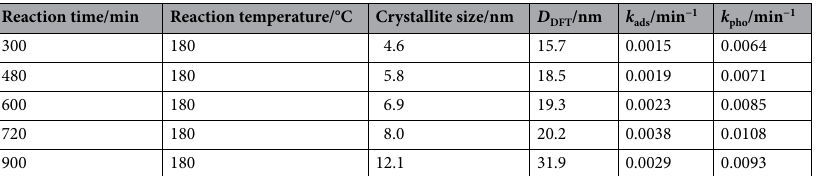
Table 2. The physicochemical properties and adsorption/photodegradation rate constants of the synthesized carbon ferrite materials in melted bases after various reaction times and reaction temperatures.